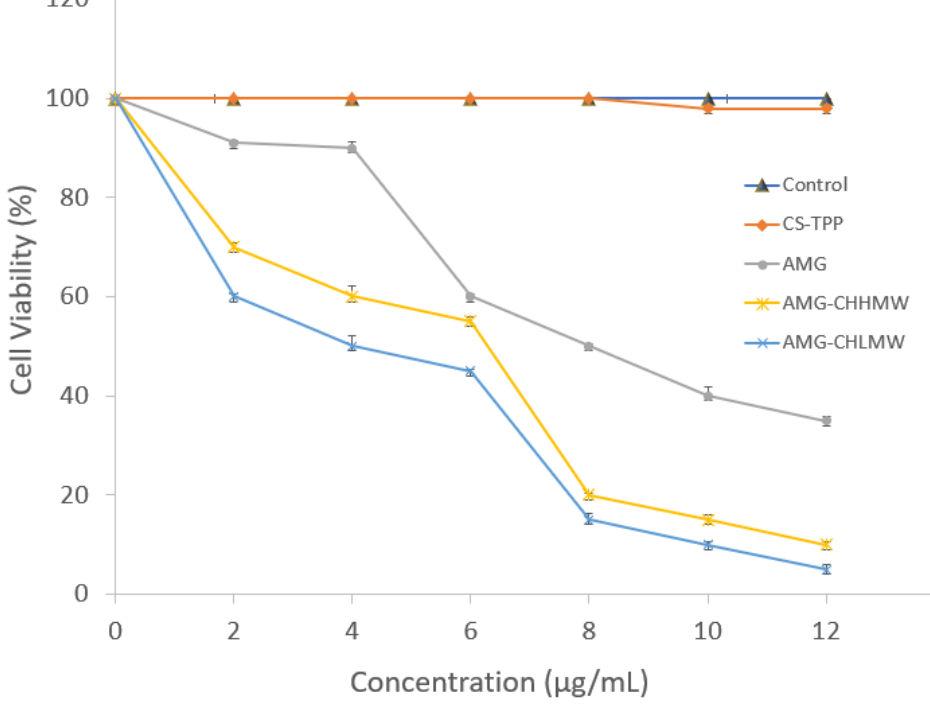
Figure 7. In vitro cytotoxicity of AMG, CS-TPP, AMG–CS–HMW NPs, and AMG–CS–LMW NPs MCF-7 cells based on the MTT assay.